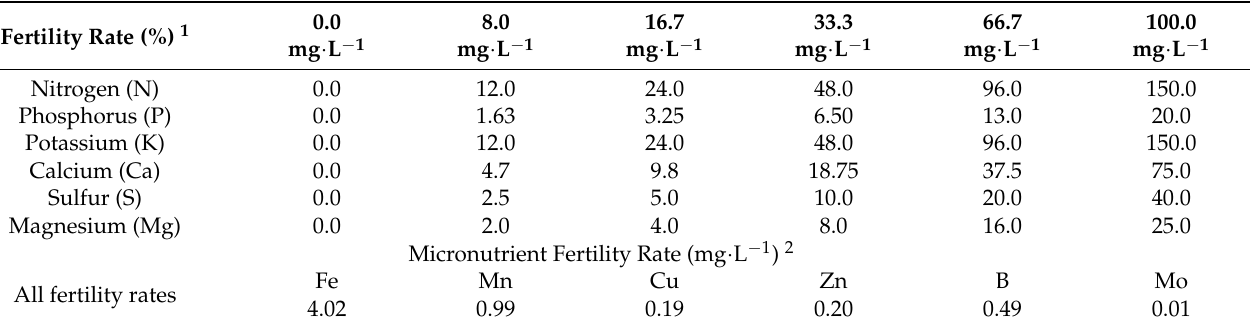
Table 1. Calculations for modified Hoagland’s solution were utilized to explore the impacts of varying macronutrients on the growth of Lactuca sativa ‘Salanova Green’. Values indicate the adjusted fertility concentration provided from a modified Hoagland’s solution with all elements held constant except the adjusted macroelement being